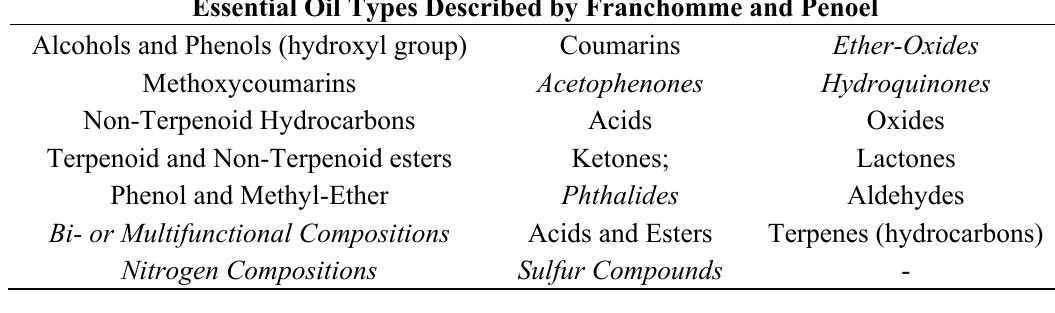
Table 2. Essential oil pharmacological types defined by functional group [2].